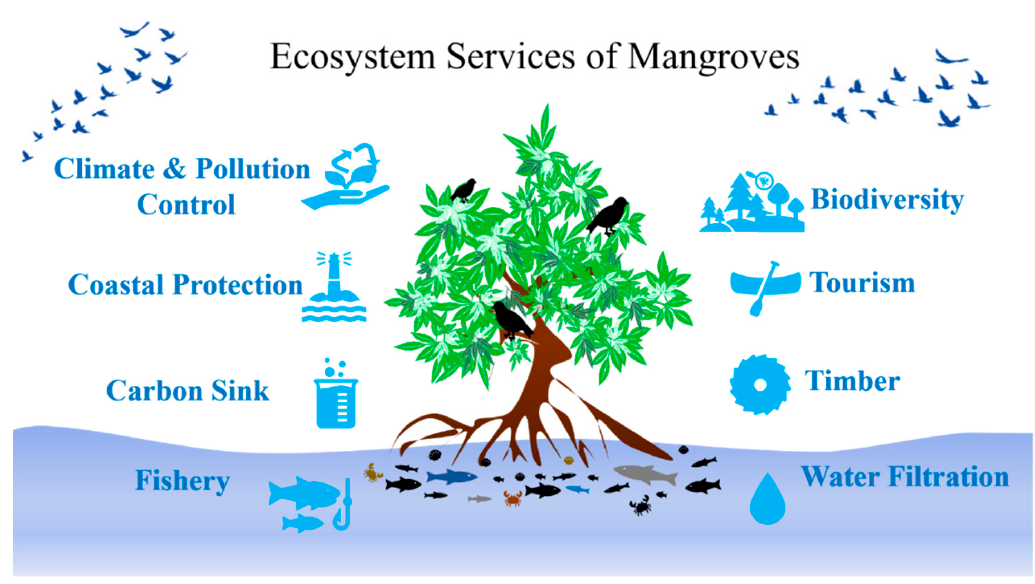
Figure 1. Ecosystem services of mangrove forests.